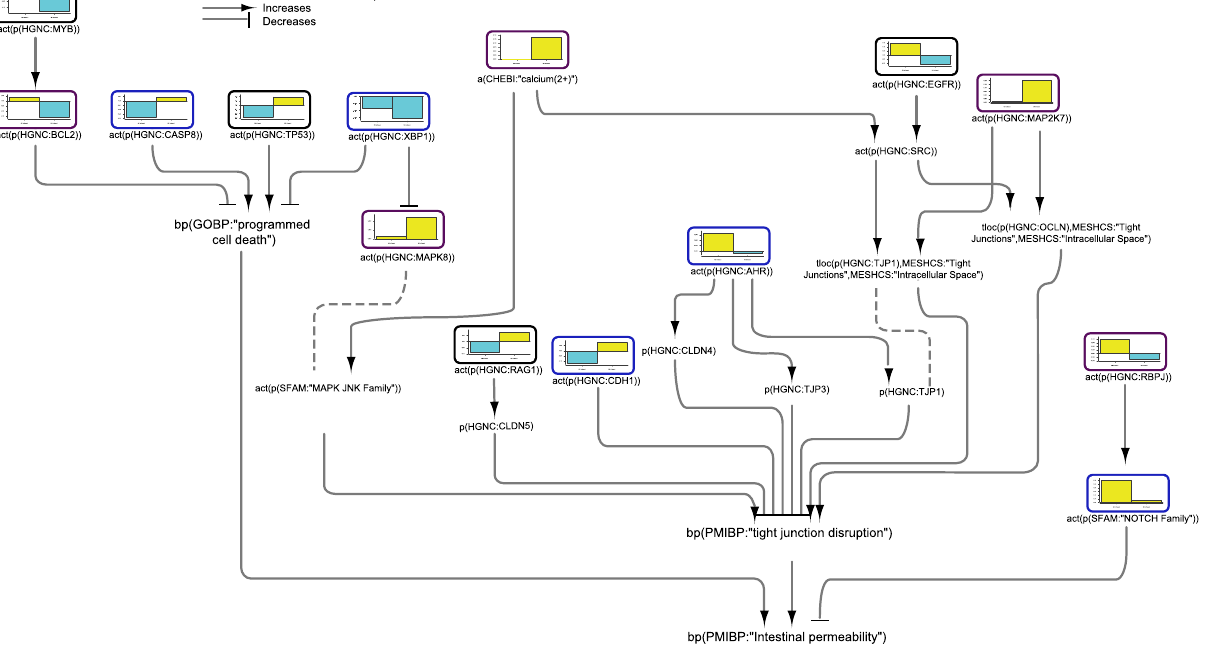
Figure 3. Impact of IBD on signalling pathways leading to intestinal permeability in colonic mucosa. The subgraph extracted from the merged IBD network model shows the iNode enrichment score for each node when scored with comparative transcriptomic data from IBD-affected versus healthy control samples. The values are not comparable between the graphs, and the scale is adjusted on the basis of the highest value for each node. Most intermediate nodes that were not scored have been removed for simplicity (The complete results are in Supplementary file 1). Black outlines indicate nodes that were significantly impacted in both CD and UC samples; blue outlines indicate nodes that were significantly impacted in CD samples; and purple outlines indicate nodes that were significantly impacted only in UC samples. The directionalities are shown as yellow or turquoise bars for inferred upregulation or downregulation, respectively. The order is as follows: 1) CD colon and 2) UC colon. Abbreviations: act, protein activity; p, protein abundance; bp, biological process. HGNC is the namespace for human proteins; GOBP is the namespace for biological processes; MESHD is the namespace for diseases; and GOCC is the namespace for complexes. SFAM and PMIBP are custom namespaces for protein families and biological processes, respectively. The figure was created using Cytoscape v3.7.1 (https:// cytos cape. org). The Cytoscape graph was then exported to pdf and the layout was further modified for better readability in Adobe Illustrator 2019 (https:// adobe.